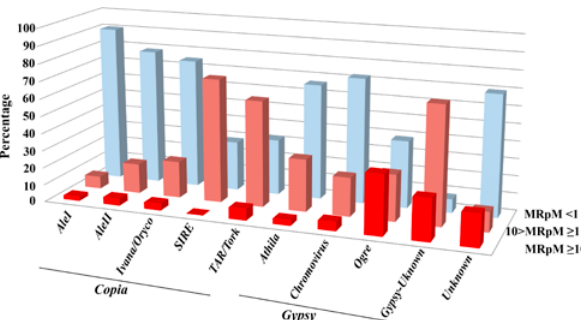
Fig. 5. Percentages of highly expressed (MRpM > 10), expressed (MRpM ranging from 1 to 10) and unexpressed (MRpM < 1) LTR- REs, distinguished among LTR-RE superfamilies and